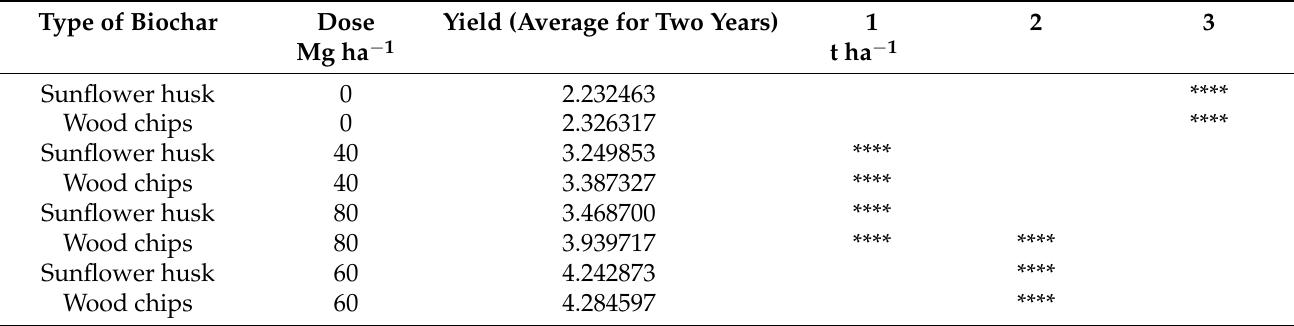
Figure 2. Efficiency of using biochar (in tonnes of soybean per hectare, Y axe) from sunflower husk (BA) and wood chips (BB). Axe X indicates doses of biochar used in the experiment. Wilks Lambda = 0.67323, F (12, 606.17) = 8, 1485, p = 0.00000. Table 2. Newman–Keuls test. Dependent variable: yield (tones of biochar per hectare). Homogeneous groups, alfa = 0.05000. Error between groups = 1.14358, df = 232.00. Columns numbered 1, 2 and 3 represent homogeneous groups whilst starts show homogeneous treatments for each